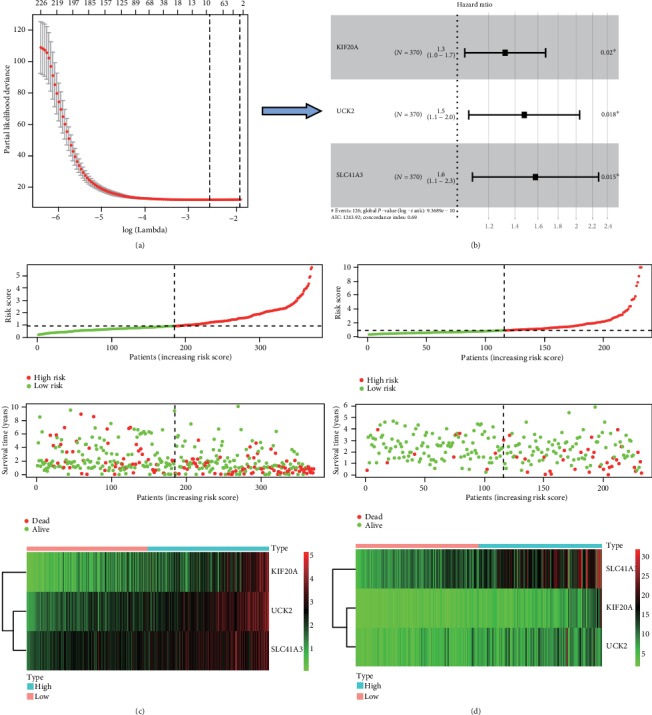
The signature-based risk score is a promising marker in the training and validation cohorts. (a, b) The process of building the signature including 3 genes which were most correlated with overall survival in the training dataset. The hazard ratios (HR) and 95% confidence intervals (CI) were calculated by univariate Cox regression, and the coefficients calculated by multivariate LASSO Cox regression. (c, d) Risk score distribution, survival overview, and heatmap for patients assigned to high-and low-risk groups based on the risk score in the TCGA and ICGC datasets.